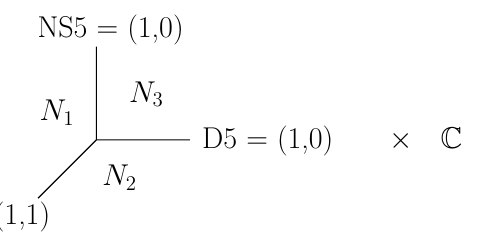
Figure 1. The simplest trivalent junction of NS5, D5 and (1 ; 1) interfaces between U( N 1 ), U( N 2 ) and U( N 3 ) gauge theories with a two-dimensional corner. The junction on the left shows the con(cid:12)guration of interfaces in the x 1 ; x 2 plane of the gauge theory with C factor corresponds to the x 3 ; x 4